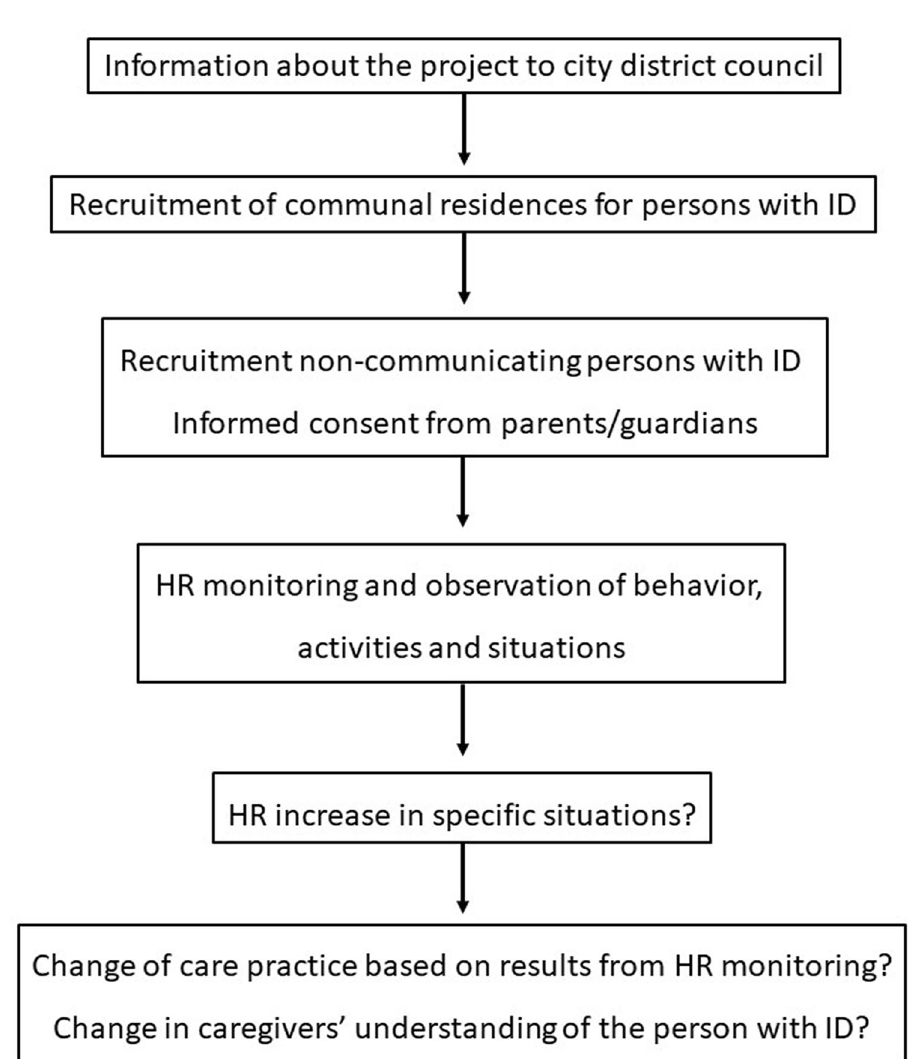
Figure 1. Flow chart of the logic of the study: the recruitment of non-communicating persons with ID, the monitoring of their HR to identify situations that may cause pain or distress, and the resulting change in care practice or in caregivers’ understanding of the non-communicating persons with